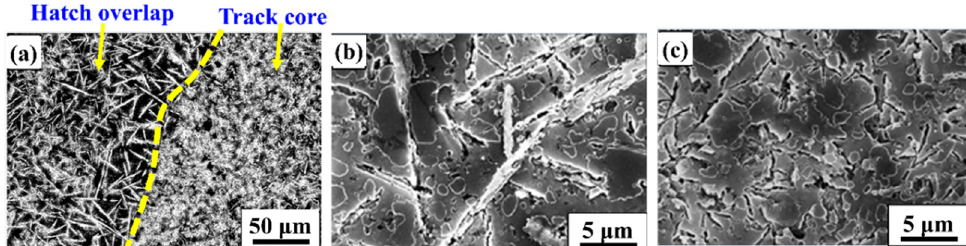
Figure 2. Images showing the scanning electron microstructures of the SLM fabricated Al-20Si-5Fe-3Cu-1Mg alloy after heat treatment at 673 K for 6 h: ( a ) low magnification image showing both hatch overlaps and track cores, ( b ) higher magnification image showing the hatch overlaps, and ( c ) higher magnification images showing track cores with fine features compared to the hatch overlaps.